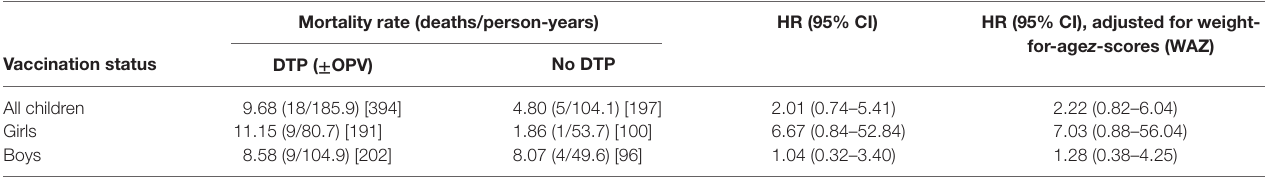
TaBle 2 | Analysis 1: mortality rates (MR) per 100 person-years and hazard ratios (HR) of 6–35 months old children who were either diphtheria–tetanus–pertussis (DTP)-vaccinated or not DTP-vaccinated at their first examination. Mortality rate (deaths/person-years)